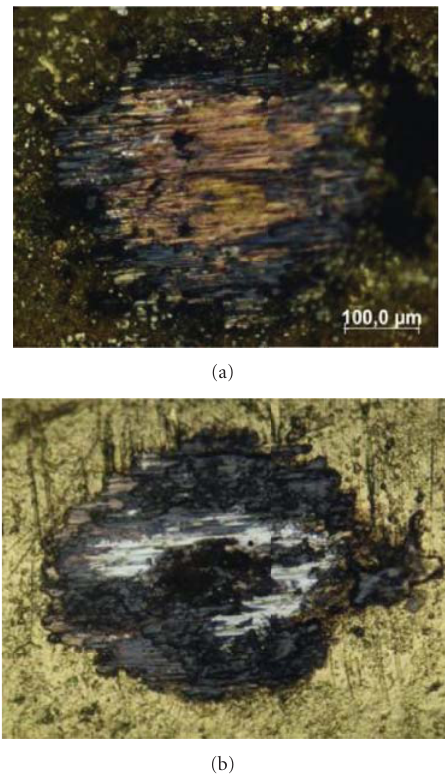
Figure 22: (a) Microscopy of contact area (average depth of wear crater: 4 μ m, contacts survive a 50,000-cycle test, nanoscale particles modified plating of 0.8 μ m). (b) Microscopy of contact area (average depth of wear crater: 6 μ m, contacts fail at 50,000-cycle, nanoscale particles modified plating of 0.8 μ